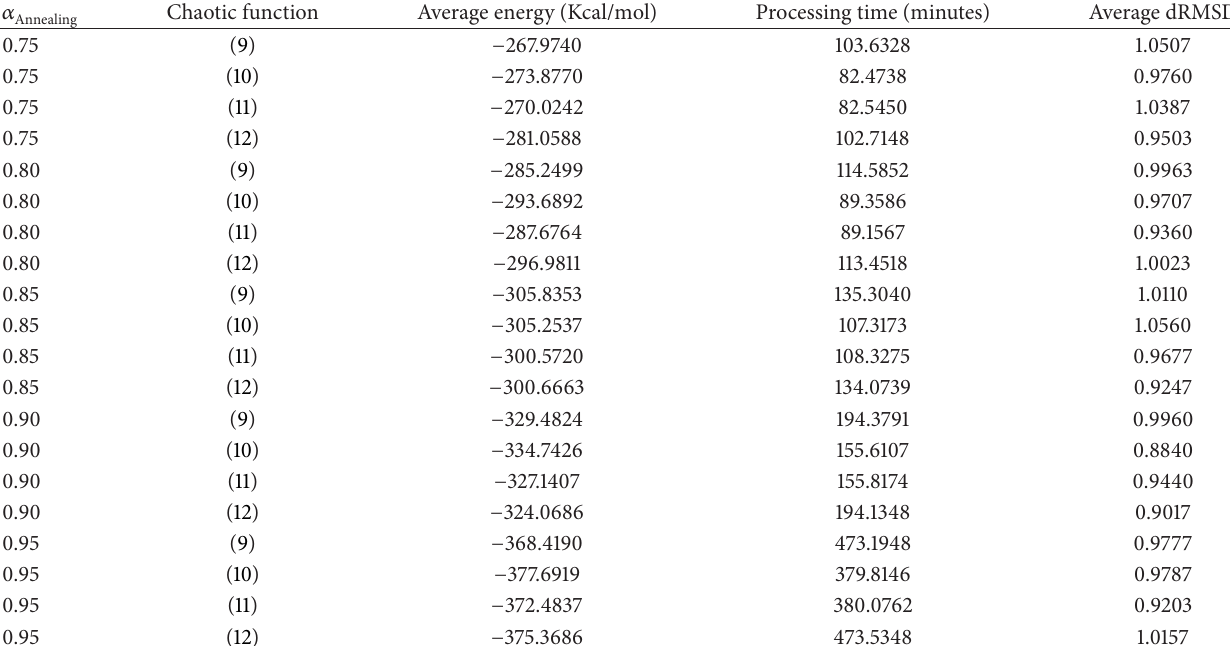
Table 5: Average results of T0335